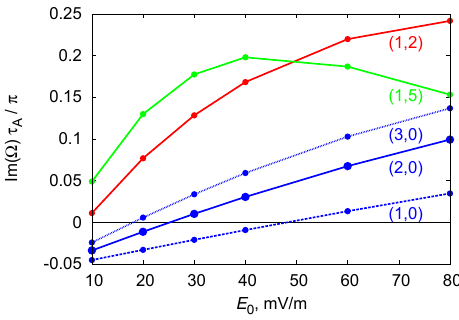
Figure 1. Growth rates γ ≡ Im ((cid:127))τ A /π of several modes (k x ,k y ) = ( 1 , 2 ) , (1, 5), (1, 0), (2, 0), and (3, 0) as functions of the convection electric field E 0 ; γ = 0 . 1 corresponds to the timescale of τ ≈ 2 .